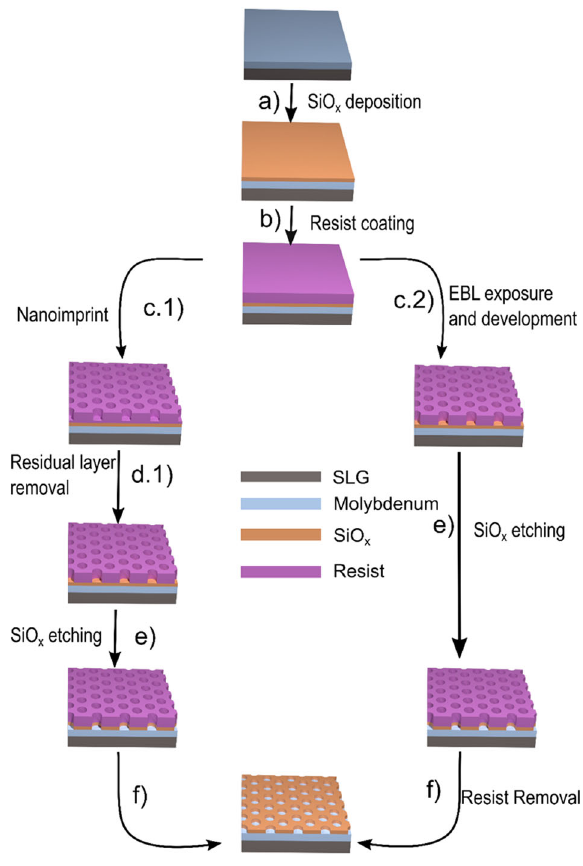
Fig. 7 Rigid substrates lithography process. Schematic representa- tion of the lithography process for patterning SLG-based substrates with NIL (Left) and EBL (Right). The fabrication steps are as follows: ( a ) SiO x deposition; ( b ) Resist coating; ( c ) Lithography exposure; ( d ) Residual layer removal; ( e ) SiO x etching; and ( f ) Resist Removal. Schematic, not at